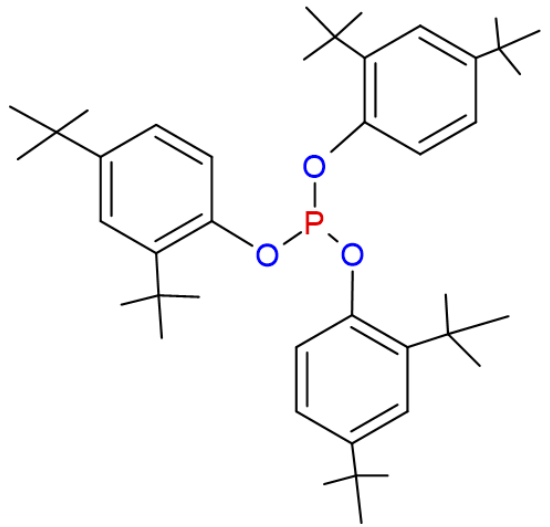
Figure 1. Chemical structure of Irgafos P-168.